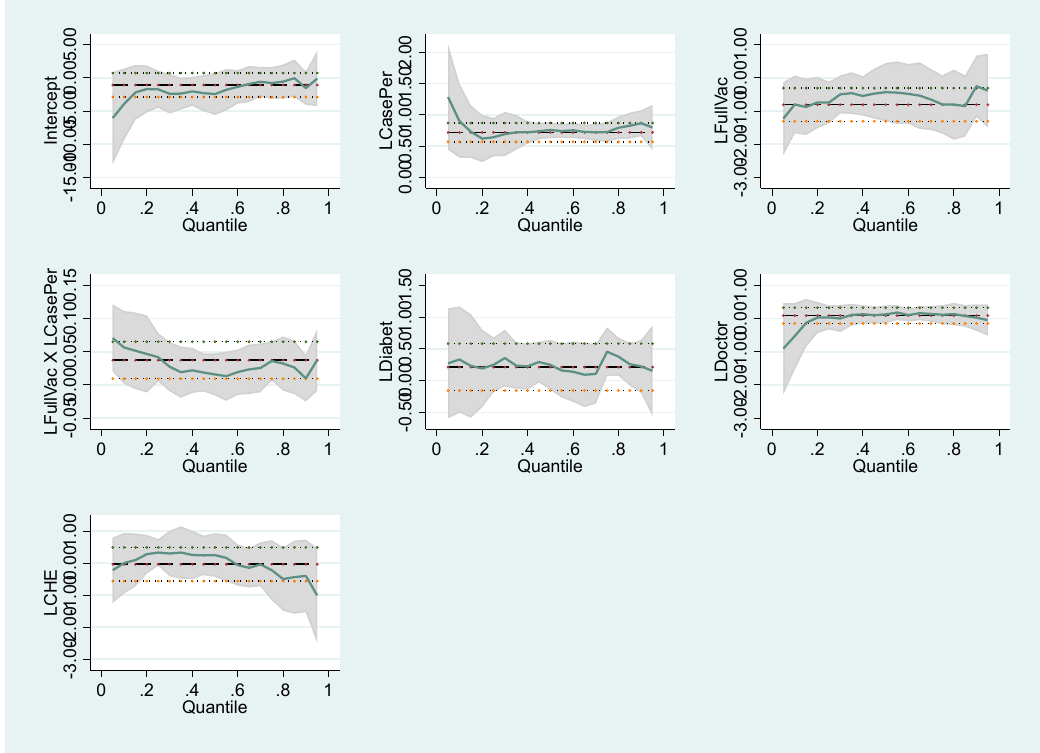
Figure 3. Changes in the quantile regression coefficients for Model III. Notes: The shaded bands represent the corresponding 95% confidence intervals.